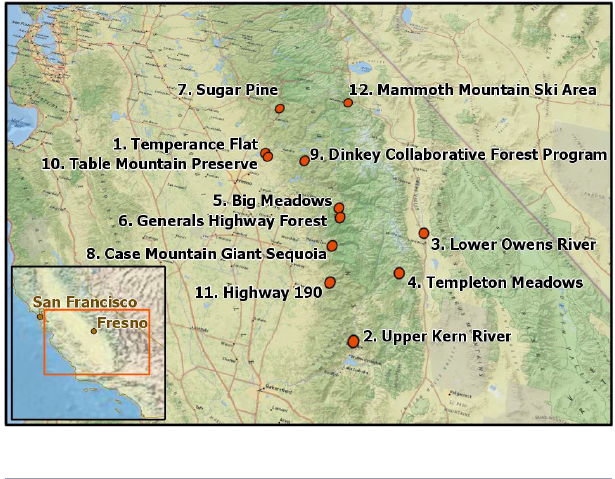
Fig. 1 . Study sites in the southern Sierra